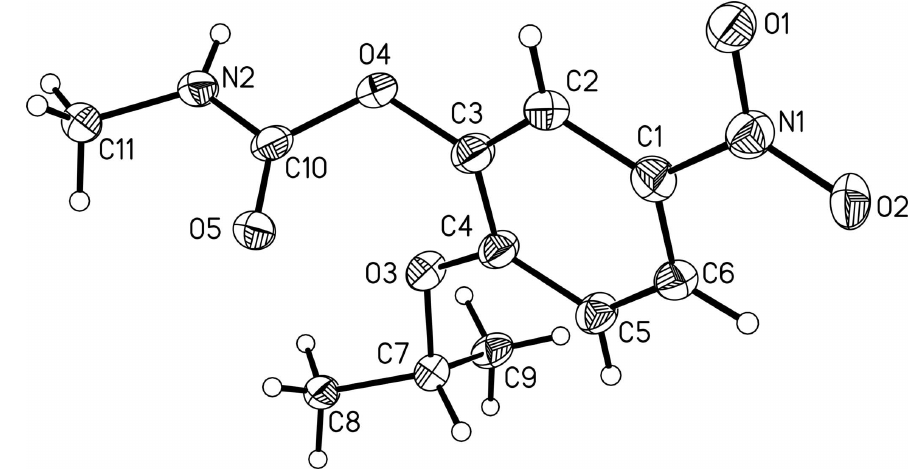
Figure 1 The molecular structure of (I), with atom labels and 30% probability displacement ellipsoids for non-H atoms.